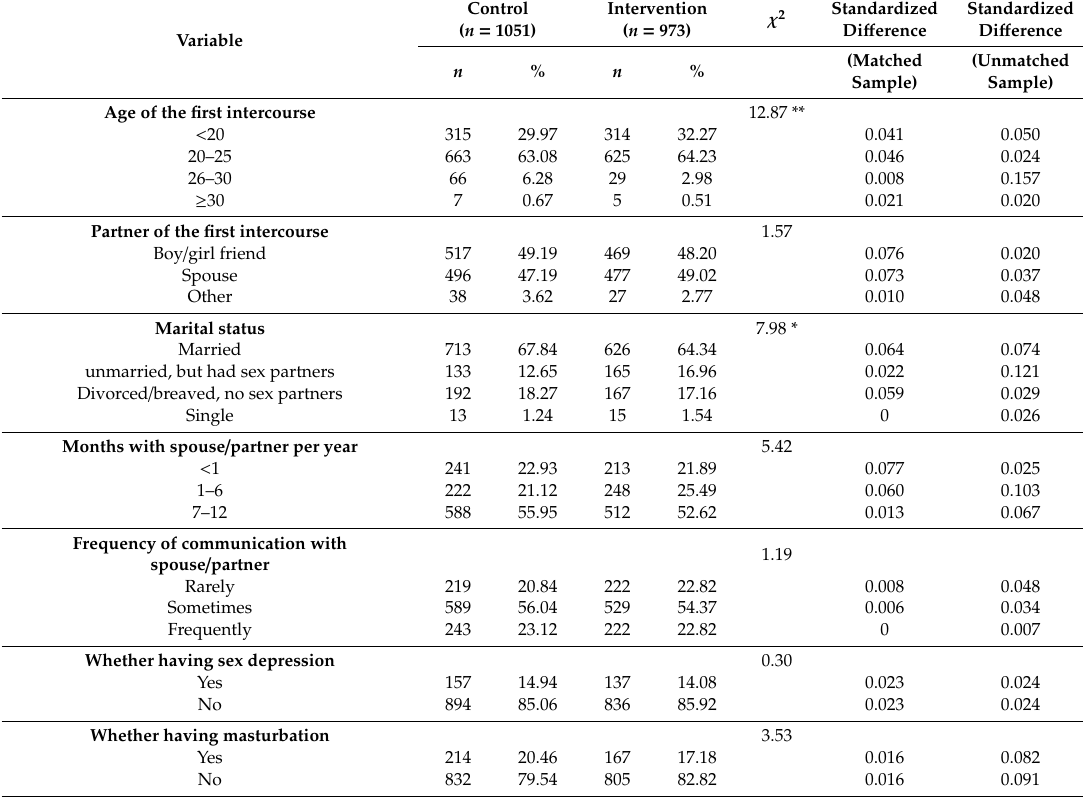
Table A8. Comparison of sexual and marital characteristics among participants between intervention and control groups in Chongqing ( n =